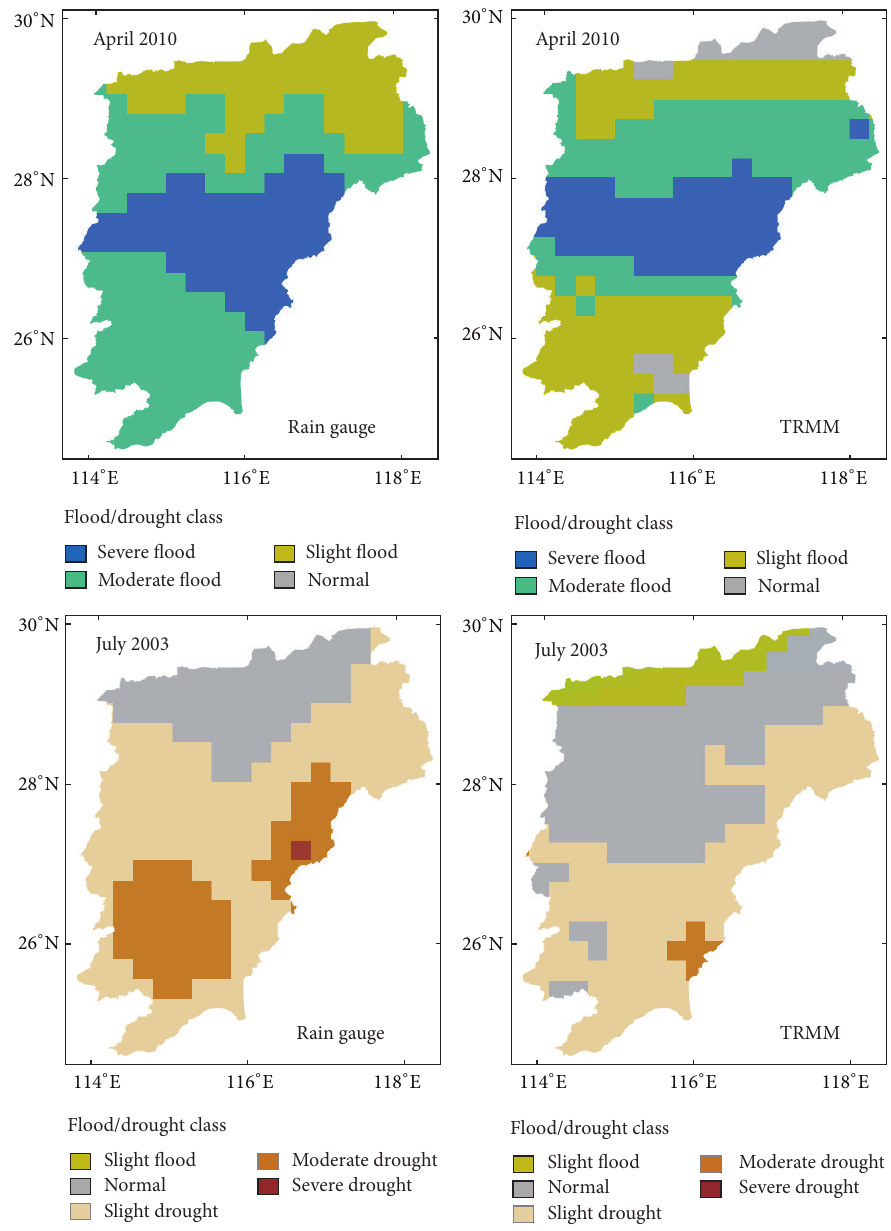
Figure 9: Spatial distribution of flood/drought classes based on the interpolated gauges rainfall and TRMM data in April 2010 and July 2003.